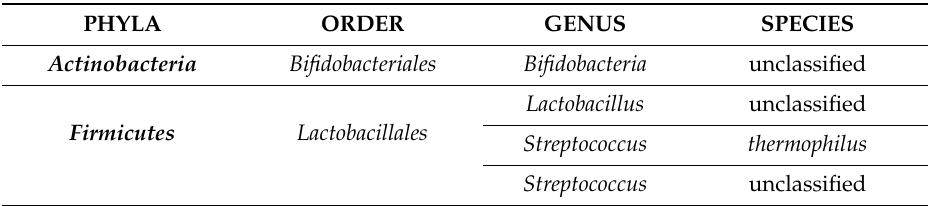
Table 2. Taxonomic a ffi liation of genera and species, which are known to contain e ff ective